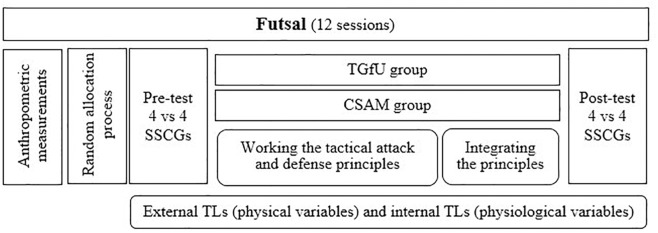
Scheme of the study design and data collect protocol.